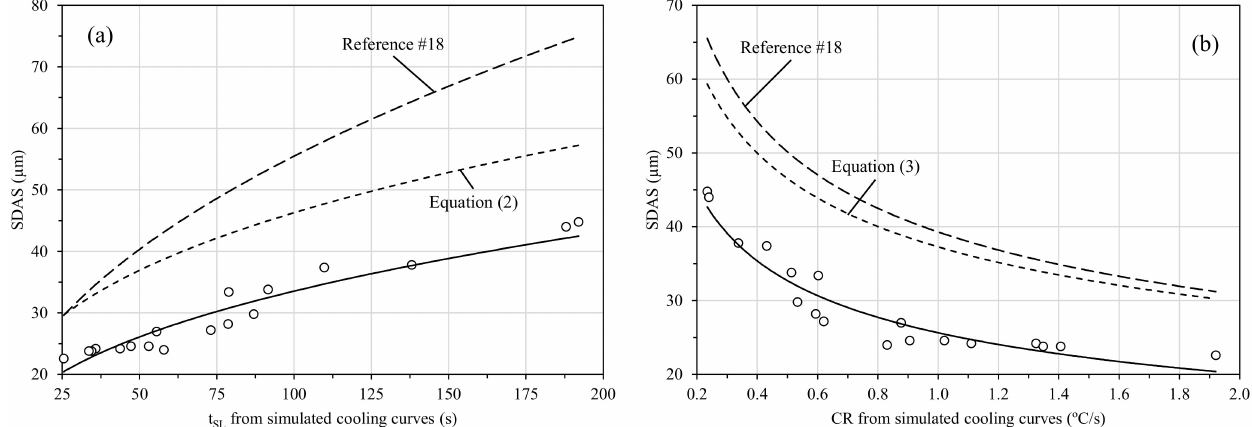
Figure 8. Evolution of experimental (dots and solid lines) and calculated SDAS (interrupted and dotted lines) in the SK-1 to SK-6 castings with ( a ) t SL and ( b ) CR, both parameters determined from the simulated cooling curves. Interrupted lines correspond to data from